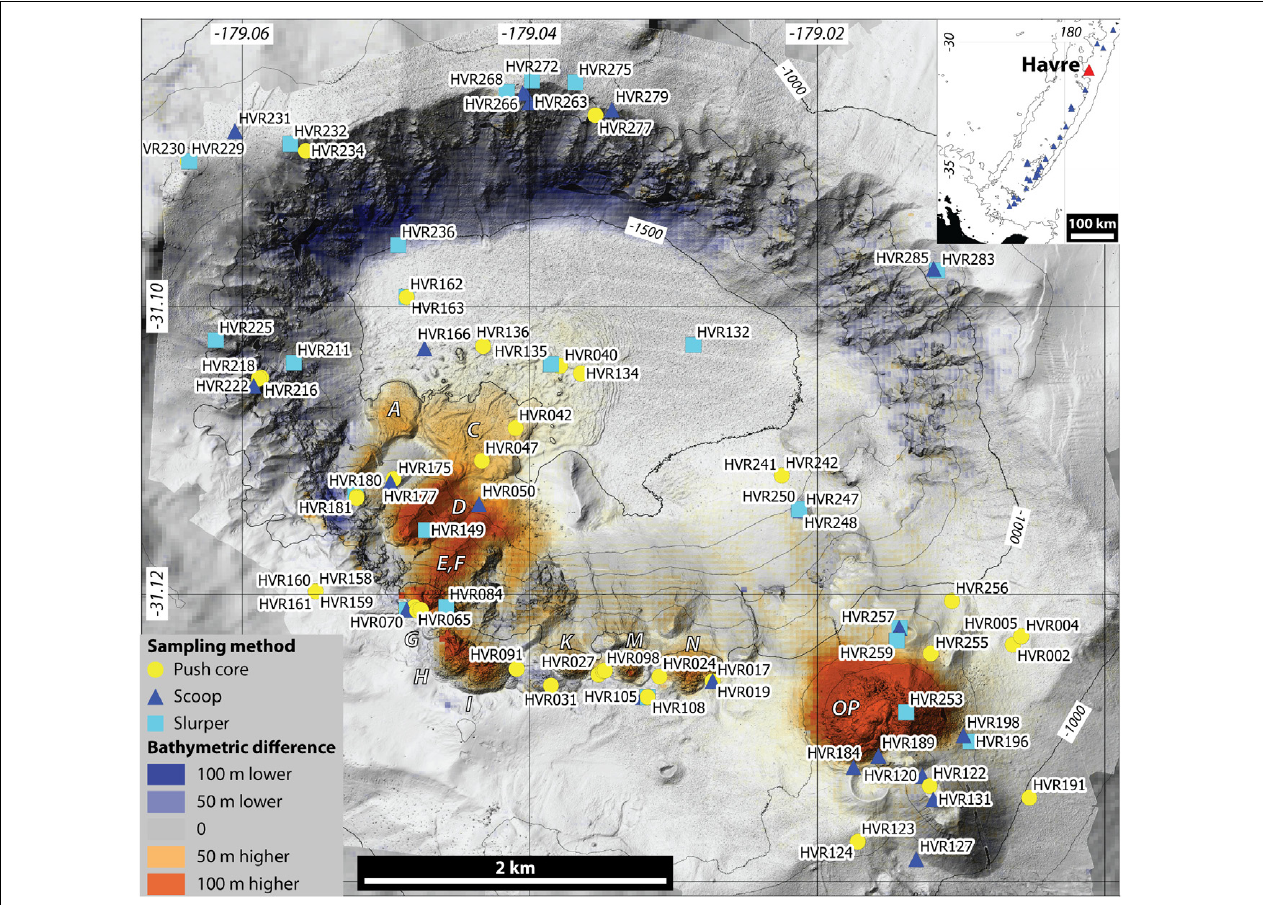
FIGURE 1 | A bathymetry map of the Havre caldera and summit with meter-scale resolution, overlain on a lower resolution (35 m) bathymetry map of the region. Overlay shows the bathymetry differences between the 2002 and Oct 2012 surveys (orange = material added, blue = material removed). The locations of all clastic samples taken at Havre are shown along with the sampling method used. Insert shows the location of Havre seamount (red) along the Kermadec